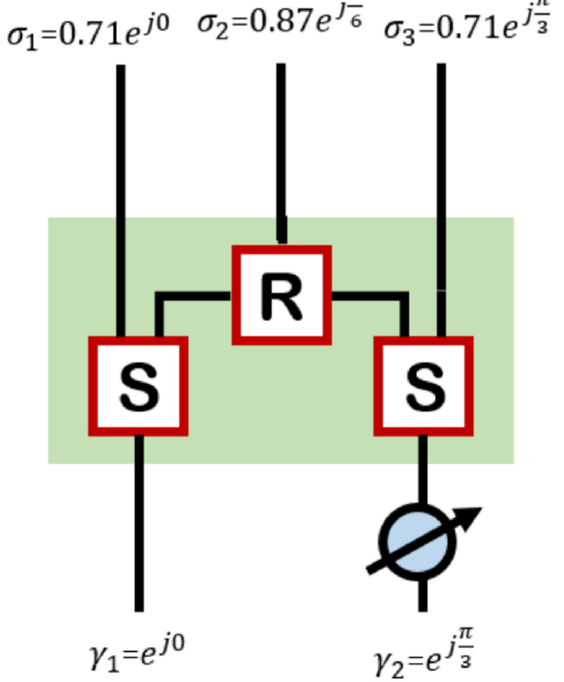
Figure 2. CORPS feeding network of 2 input ports and 3 output ports.